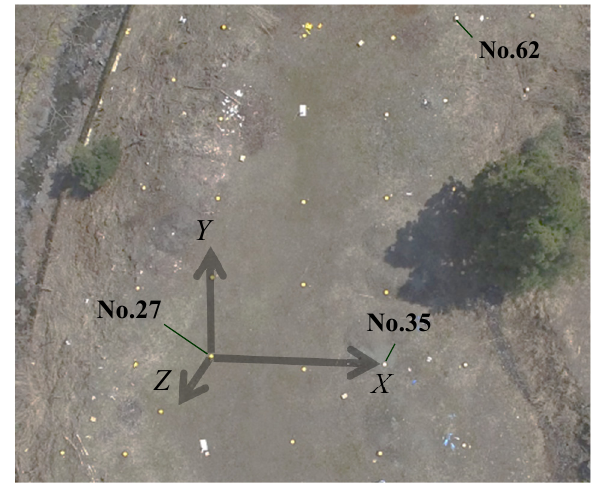
Figure 9. Local coordinate system